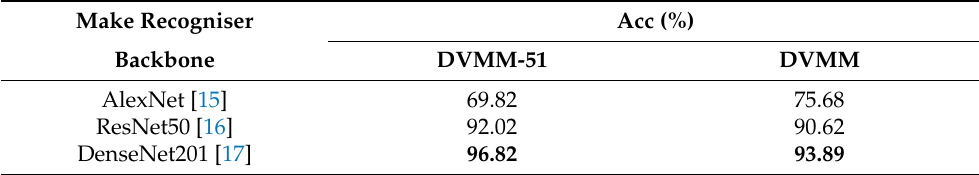
Table 4. Make recognition results with different backbones over DVMM and DVMM-51.